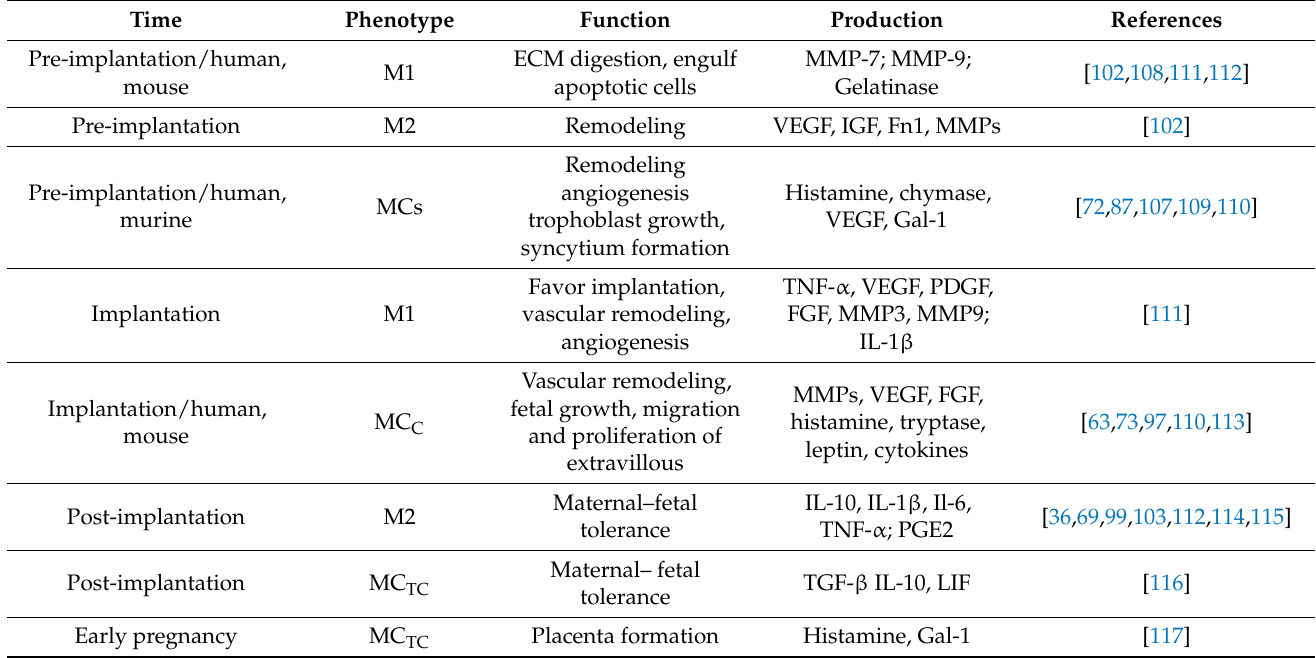
Table 3. MCs and M φ s phenotypes, functions, and biomolecules produced during different stages of early pregnancy. Abbreviations: MC C —mast cell chymase, MC TC —mast cell